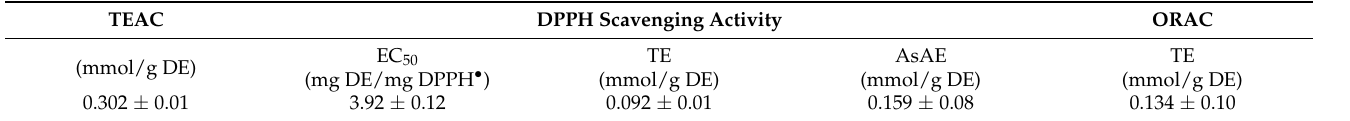
Table 4. Antioxidant activity of R. rugosa root crude polysaccharide determined with Trolox equivalent antioxidant capacity (TEAC), DPPH • radical scavenging activity, and oxygen radical absorbance capacity (ORAC) assays.